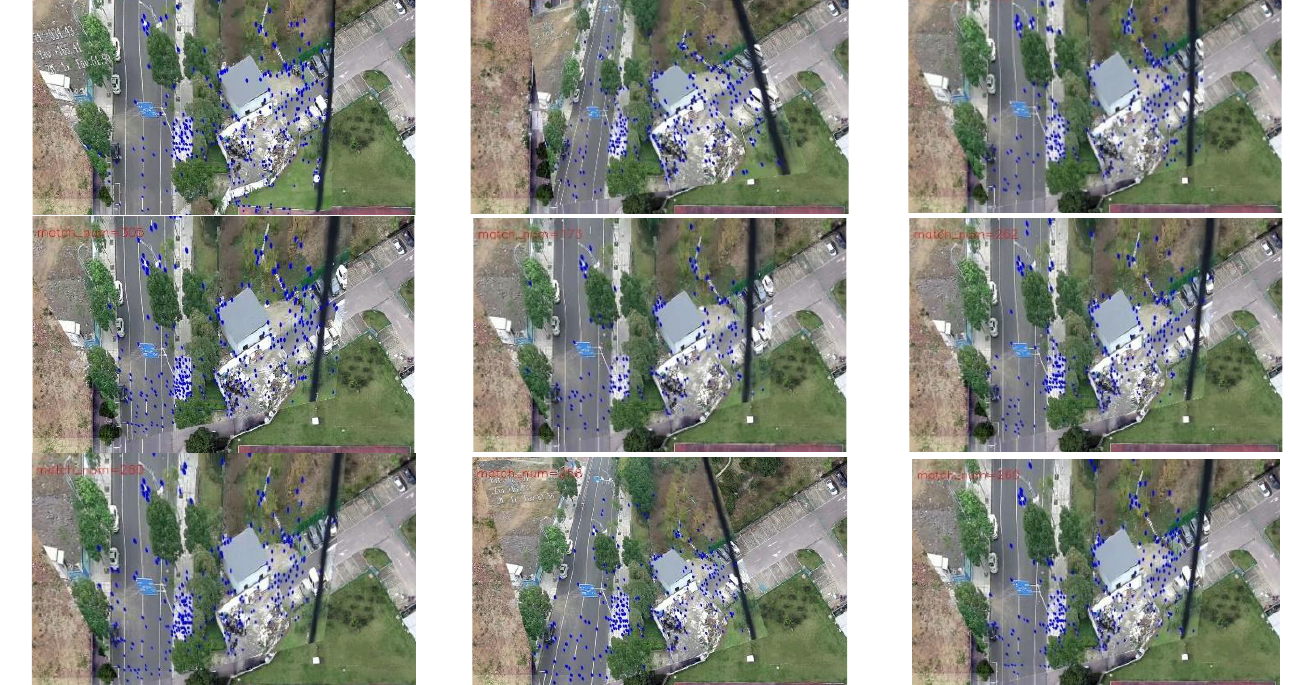
J. Imaging 2023 , 9 , 67 Figure 24. Registration image (without updating the map features). Figure 24. Registration image (without updating the map features).